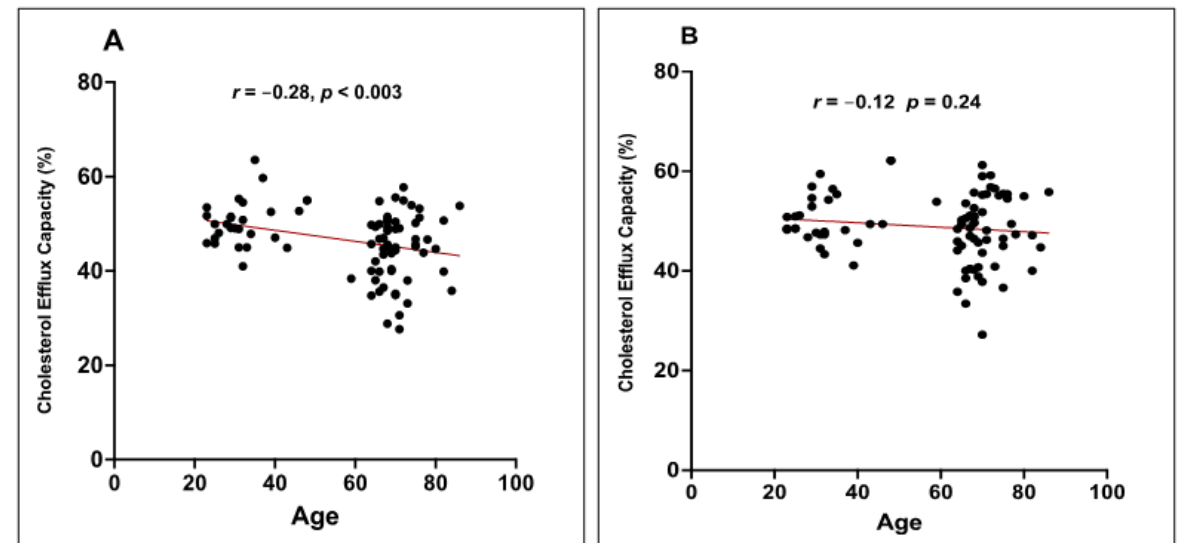
Figure 3. Effect of EVOO consumption on the correlation between age and the CEC of HDL. Healthy young and elderly subjects consumed EVOO for 12 weeks. The CEC of HDL from each age group (young and elderly) were evaluated for their CEC. The CEC of HDL was measured at T0 ( A ) and T12 ( B ). A Pearson’s correlation analysis was performed to determine the correlation between age and the CEC of HDL before and after EVOO consumption.